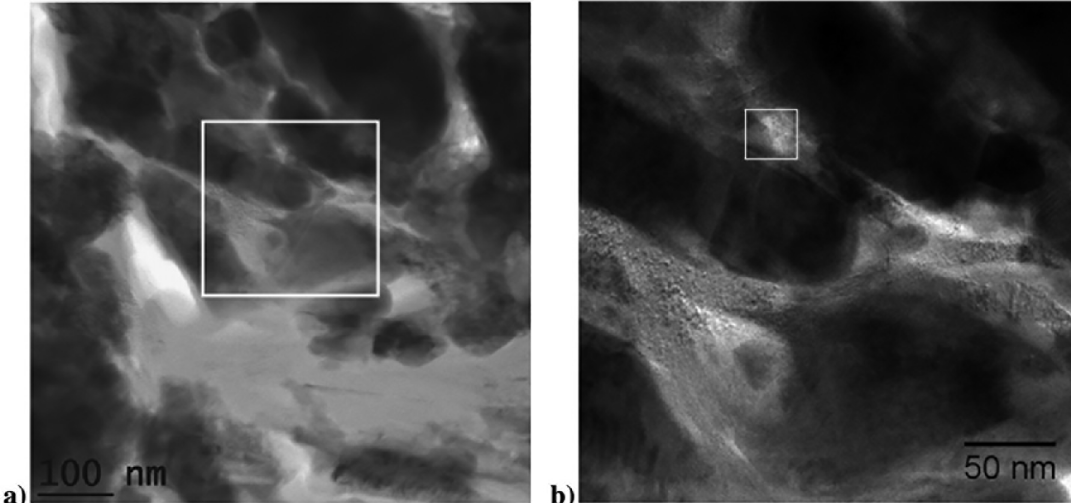
Figure 4. EFTEM images showing a thin graphite lamella between magnetite and iron grains at the boundary between the graphite flake and the iron matrix; a) overview; b) higher magnification of the area of the white square in (a). The small white square in (b) indicates where the high resolution image (Fig. 5a) was made.